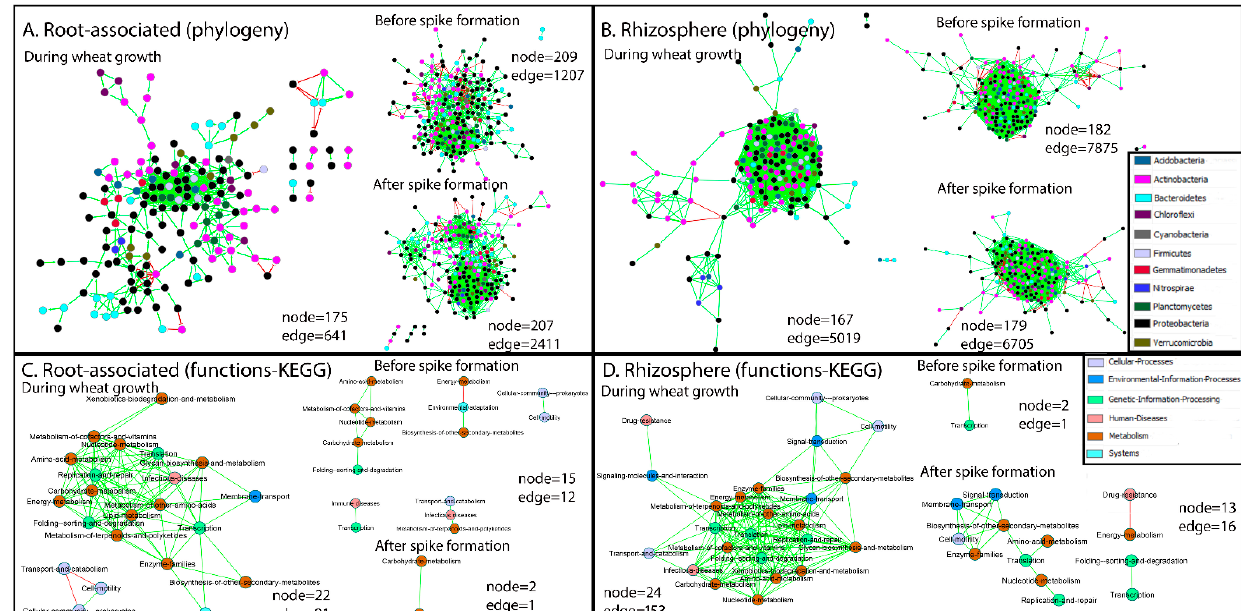
Figure 3. Network co-occurrence analysis of bacterial communities of root and rhizosphere samples constructed using CoNet, a Cytoscape plugin. Green and red links (i.e., edges) indicate significant positive and negative correlations between two nodes, respectively. In ( A , B ), each node represents taxa affiliated to all taxonomic levels from the metagenome, labeled at the phylum level. In ( C , D ), each node represents a group of functional genes, annotated with known KO groups from the KEGG database.